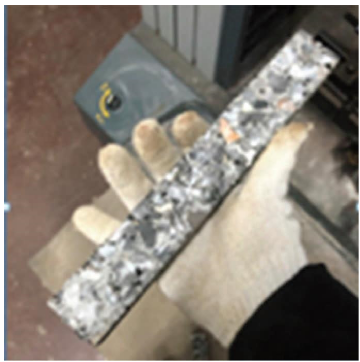
Figure 7: Specimen after low-temperature